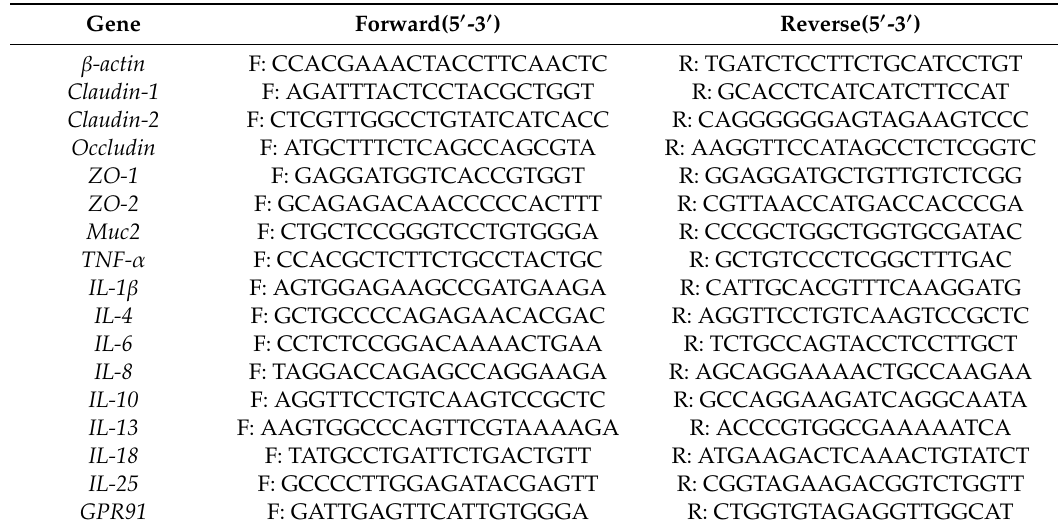
Table 1. List of PCR